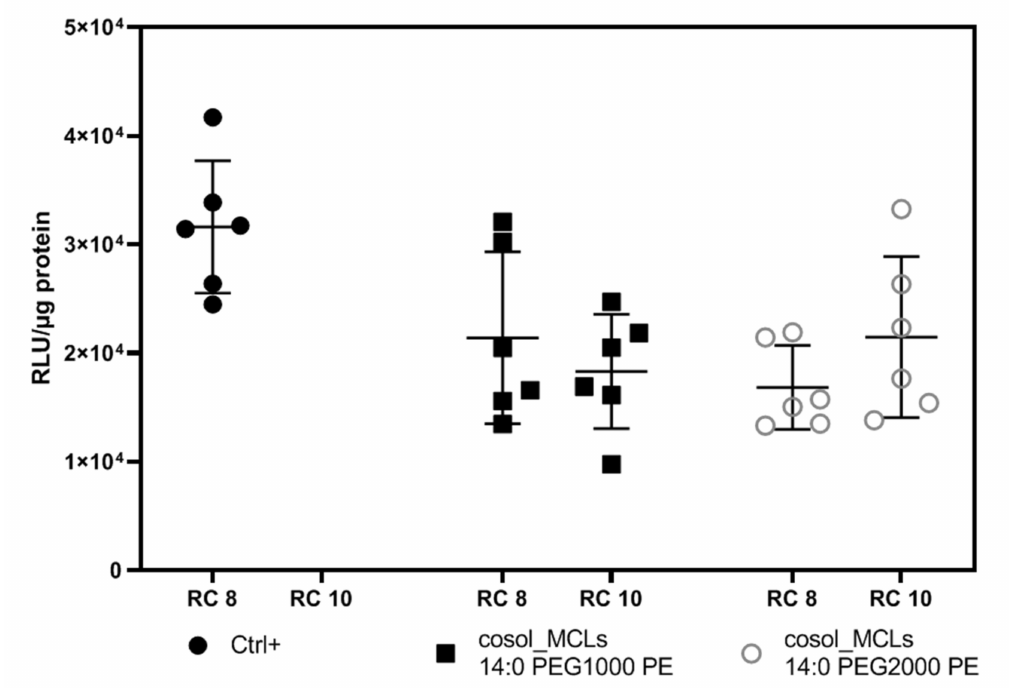
Figure 16. Transfection e ffi ciency of lipoplexes based on cosol_MCLs with di ff erent PEG-PE in CT26 cell line. Cells were seeded at 10 4 cells / well in a 96-well plate. Luciferase and protein assay were carried out 24 h after incubation of cells with 100 µ L of lipoplexes containing 1 µ g of pFAR4-luc in the absence of magnetic field for 3 h. Transfection e ffi ciency is calculated as RLU / µ g protein. The data given are averages of 2 di ff erent experiments, each performed in triplicates ( n = 6); bars, SD. RLU, relative light unit; RC = nmol DMAPAP / µ g pFAR4-luc. Ctrl + (dark circle): positive control (lipoplexes based on liposome DOPE / DMAPAP / C14PEG1000 49:50:1 mol / mol); cosol_MCLs: lipoplexes based on cosols MCLs with 1% of 14:0 PEG1000-PE (dark square) or 14:0PEG2000-PE (clear